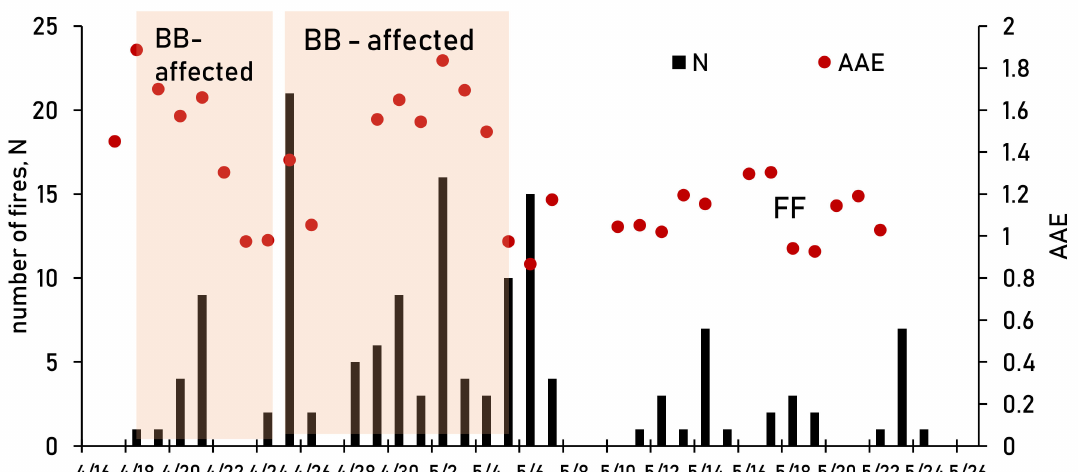
Figure 3. Absorption Angstrom Exponent (AAE) obtained from spectral dependence of aerosol light attenuation and number of fires (N) passed by air